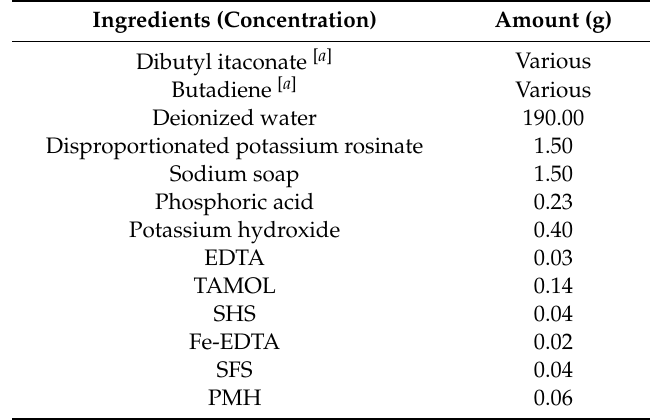
Table 1. Recipe for redox-initiated emulsion polymerization of